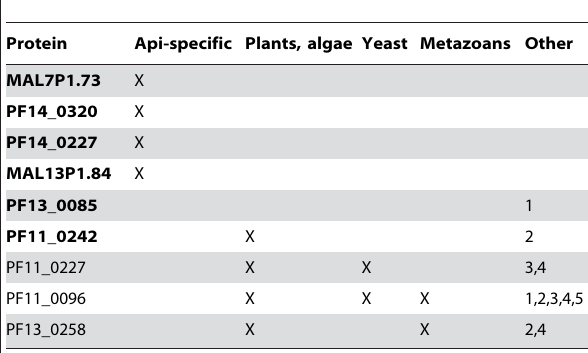
Table 5. Phyletic distribution of the 9 kinases for which interspecies correlations exist.